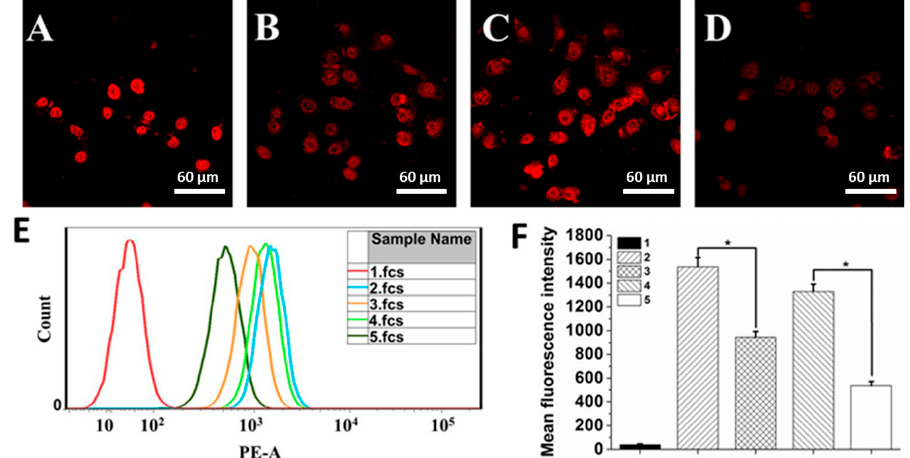
Figure 5. Confocal images of HeLa cells incubated with ( A ) free DOX, ( B ) BPQDs-PEG/DOX, ( C ) BPQDs-PEG-FA/DOX and ( D ) BPQDs-PEG-FA/DOX + free folic acid after incubation for 2 h. ( E ) Flow cytometry (FCM) histogram profiles of cellular DOX fluorescence intensities in HeLa cells after 1 h incubation. ( F ) Quantification analysis of DOX fluorescence intensity in HeLa cells after incubation for 1 h. 1, 2, 3, 4, and 5 represent control, DOX, BPQDs-PEG/DOX, BPQDs-PEG-FA/DOX, and BPQDs-PEG-FA/DOX + free folic acid, respectively. (* p < 0.05).